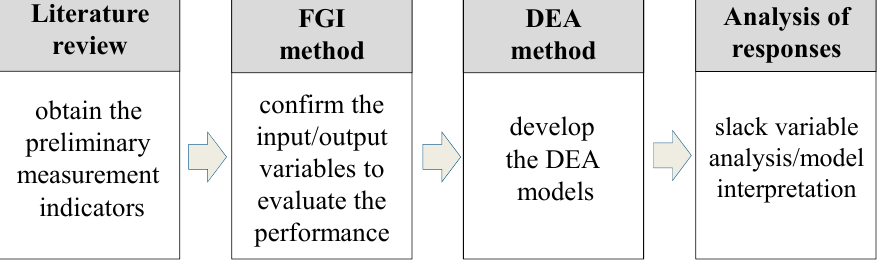
Figure 1. Research scheme .